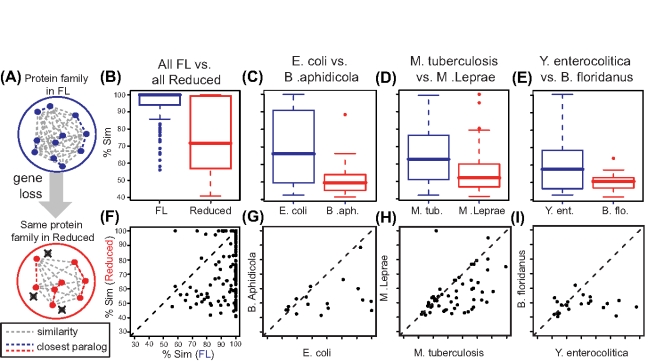
Closest paralogues are preferentially lost.(A) Cartoon representing the similarity network in one protein family in free living organisms blue circle, with the most similar paralogues highlighted (in blue lines). Selective gene loss in reductive genome evolution removes preferentially those genes that have the most similar paralogues resulting in a Reduced family similarity network (in red), where the closest pairs of paralogues are more dissimilar. Thus the prediction is that the closest pairs of paralogues in FL are more similar than the closest pairs in Reduced. The similarity between the closest paralogues in the similarity network in each protein family is significantly lower in Reduced genomes, when (B) all genomes are considered (p = 1.1×10−22, Wilcoxon test), as well as for phylogenetically related organisms (C–E, p = 0.03, p = 0.002, p = 0.04, respectively). (F) In 89.7% of the protein families, the closest pair of paralogues is more similar in FL than in Reduced genomes, and the same is true for the same example organisms considered (G–I, 71%, 71% and 76%, respectively). Species represented are FL: Escherichia coli, Mycobacterium tuberculosis, Yersinia enterocolitica, Reduced: Buchnera aphidicola, Mycobacterium leprae, Candidatus Blochmannia floridanus.